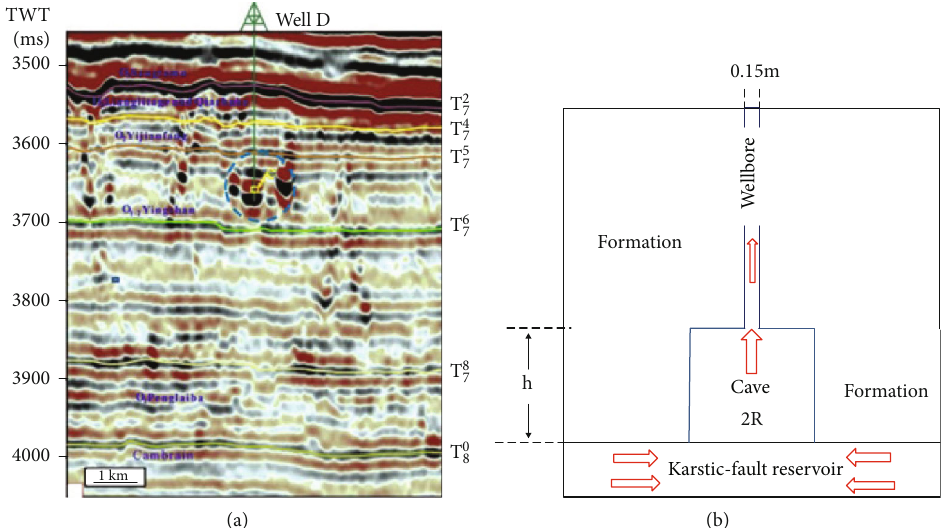
Figure 1: (a) Seismic image of karstic-fault reservoir [7]. (b) Schematic of production well, h is the depth di ff erence between the bottom-hole and the